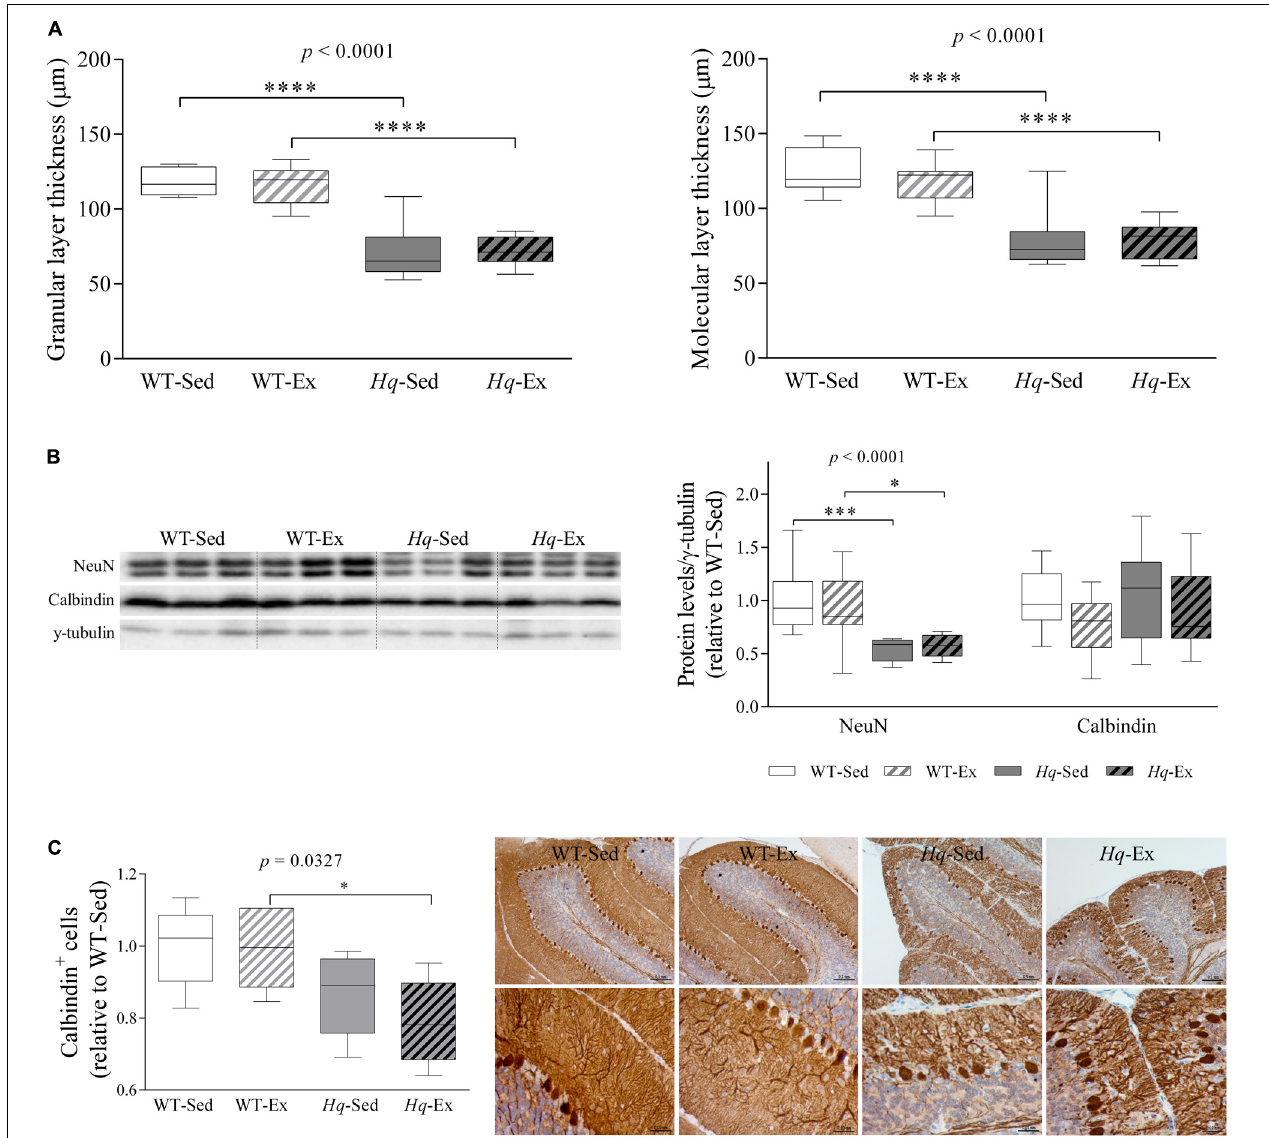
FIGURE 3 | Cerebellar atrophy and neuronal loss. (A) Mean thickness of granular and molecular layers of cerebellar cortex. Analyses were performed in 9 WT-Sed, 8 WT-Ex, 11 Hq -Sed and 9 Hq -Ex animals, using 1 section per mouse. (B) Western blot analysis of NeuN and calbindin in cerebellum homogenates of wild-type sedentary (WT-Sed, n = 12) and exercise-trained (WT-Ex, n = 11) mice, and of Hq sedentary ( Hq -Sed, n = 11) and exercise-trained ( Hq -Ex, n = 10) mice. Densitometry analysis: protein levels were normalized to γ -tubulin levels; data (median, interquartile range, and min and max values) are expressed relative to levels in the WT-Sed group. (C) Immunohistochemistry analysis of calbindin in sagittal sections of cerebellum of representative WT-Sed, WT-Ex, Hq -Sed and Hq -Ex mice (10 × and 40 × ) and quantitative analysis of calbindin-positive cells (Purkinje neurons) per mm in cerebellar cortex. Significant p- values for the group effect (Kruskal-Wallis test) are shown above the corresponding boxes. Symbols for significant differences in post hoc pairwise comparisons: ∗ p < 0.05; ∗∗∗ p < 0.001, ∗∗∗∗ p < 0.0001 for Hq -Sed vs. WT-Sed, and Hq -Ex vs. WT-Ex. Analyses were performed in 5 animals for each of the four experimental groups, 2–6 images per animal.